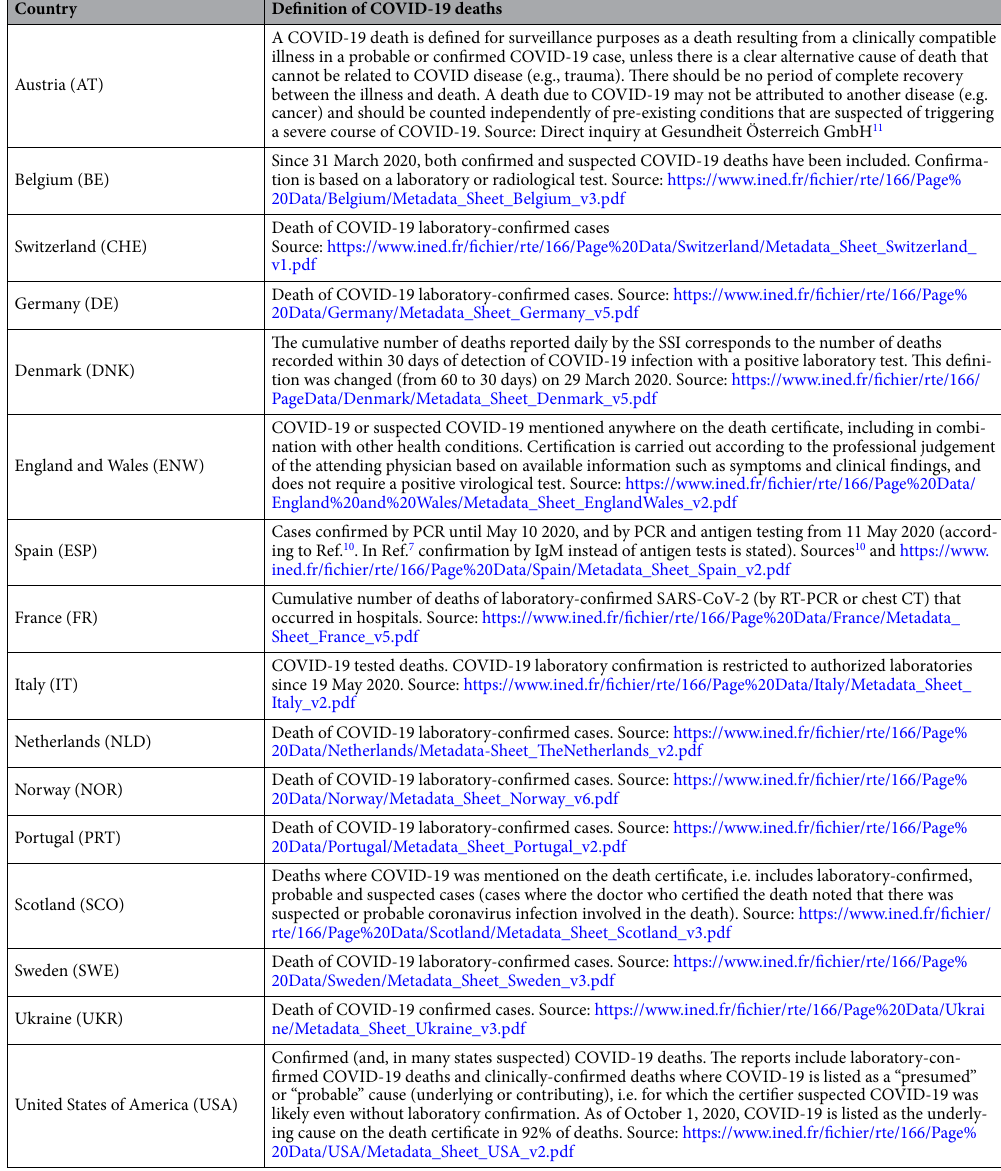
All-cause mortality. The estimated risk of all-cause deaths for women at 65 years old ranged from 0.71% (0.62– 0.82) in Spain and 0.72% (0.66–0.78) in Sweden up to a maximum of 1.83% (1.50–2.27) in Ukraine, followed by Scotland with 1.17% (1.07–1.28; see Supplementary Table 2Sb). Age dependency. COVID-19 mortality. The smallest risk ratio for age (per 10 years) for COVID-19 mortality was observed in Ukraine with 1.55 (1.20–2.00; Fig. 1 and Supplementary Table 2Sa). This means that the risk of COVID-19 mortality in women (the reference category for the variable sex) increased by a factor of 1.55